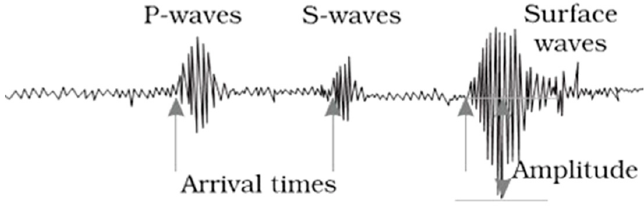
Figure 1. Earthquake seismograph and wave arrivals [3].